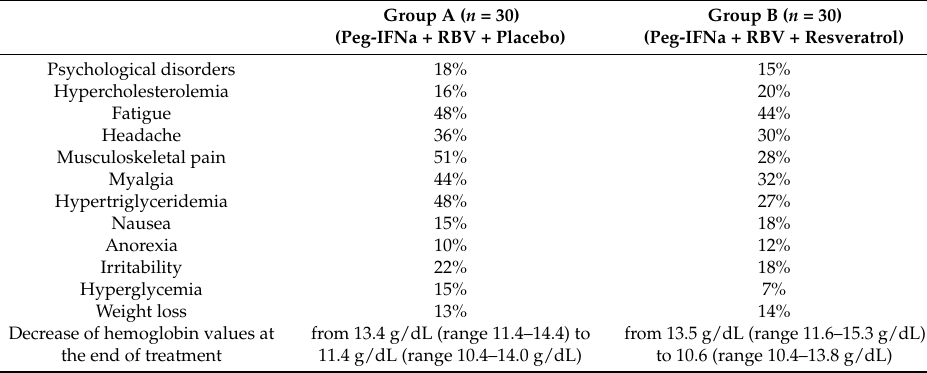
Table 5. Adverse events observed in the study